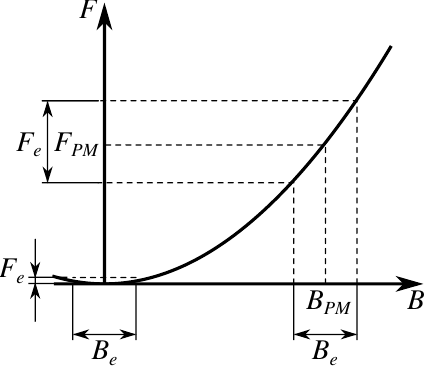
Figure 6. Position measurement